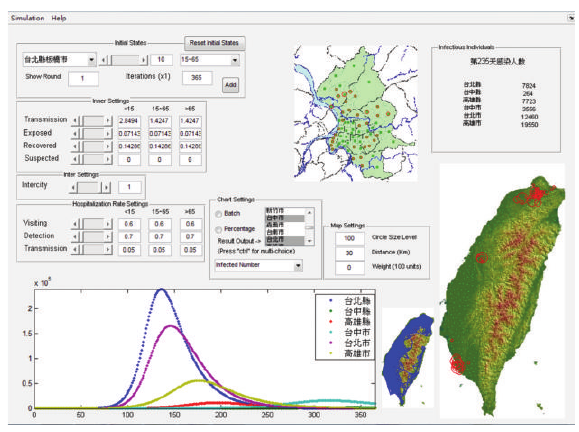
Figure 3: FLUed model simulation